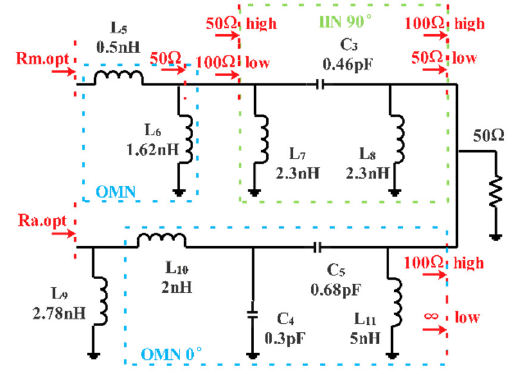
Figure 6. Output matching network.